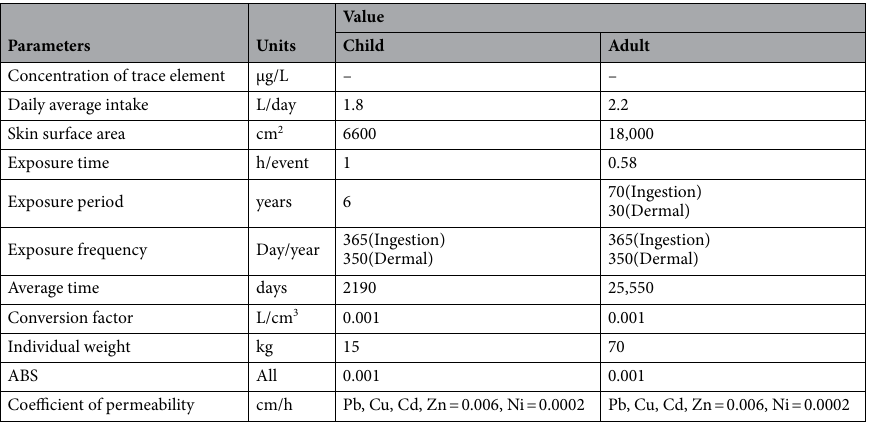
Table 1. The assumed value for CDI evaluation.